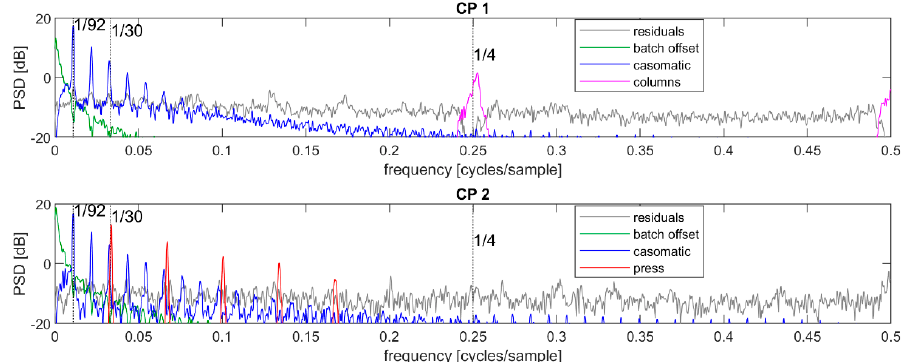
Figure 6. Top: power spectral density of the refined decomposed signal at control point CP1; bottom: same for signal at CP2 - both from 2019. The unit is in the logarithmic scale of decibel (dB) which implies a factor 10 for each increase by 10 dB.